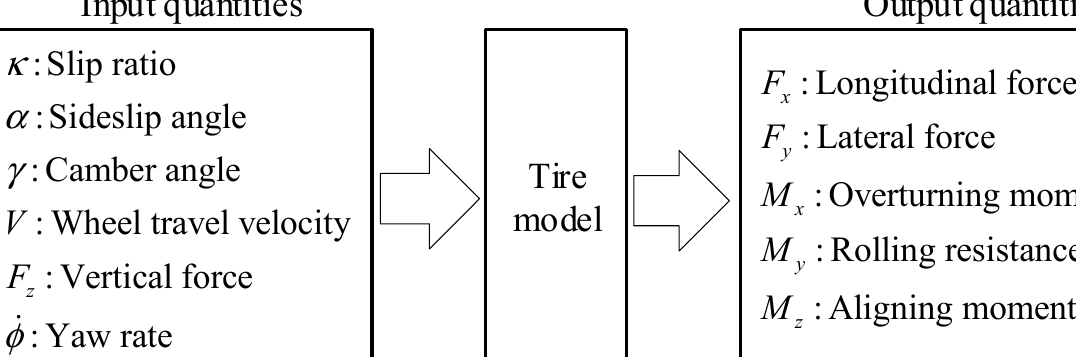
Figure 3. Input/output variables for the tire model.